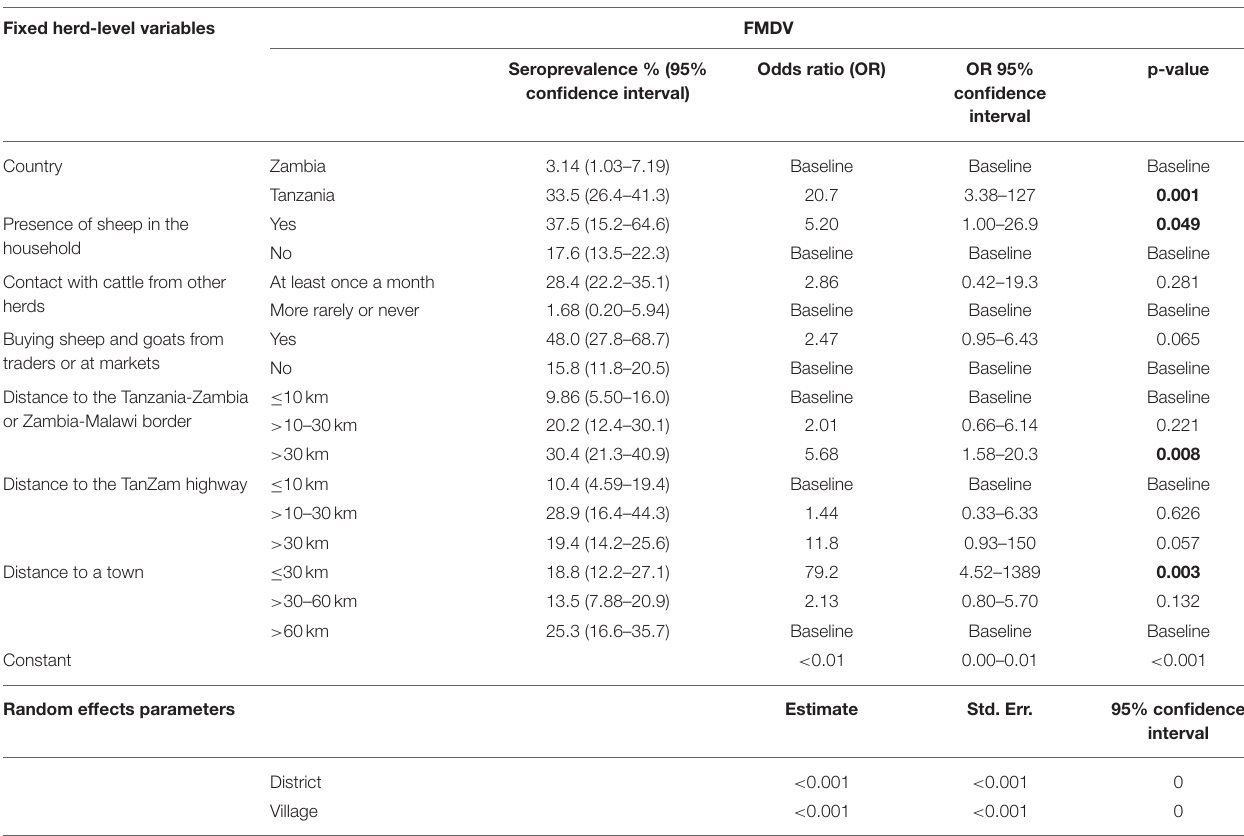
TABLE 10 | Predictor variables associated with herd-level seropositivity for